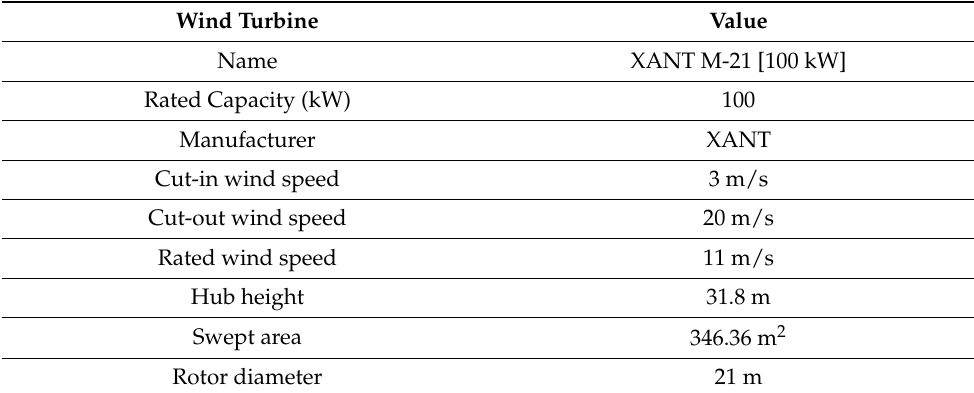
Table 3. Wind turbine details [19].